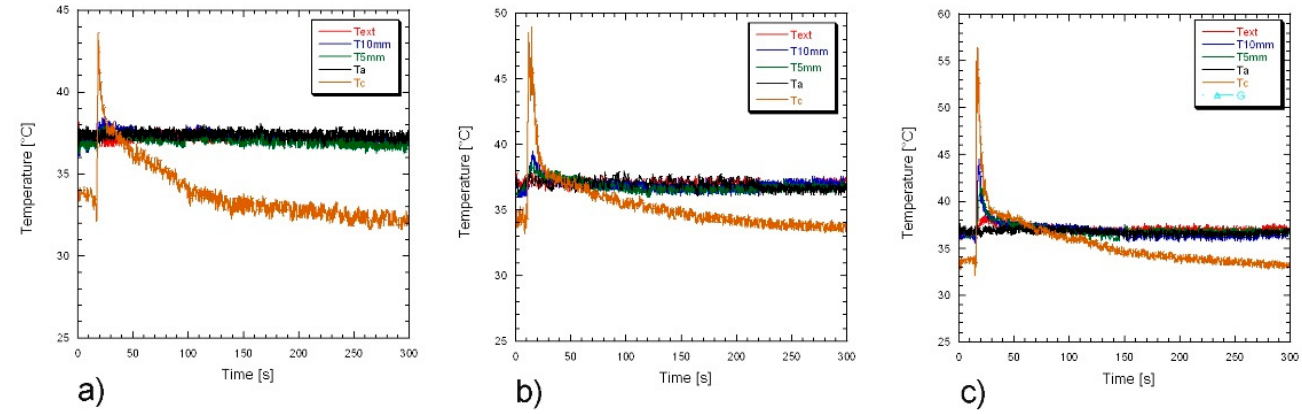
Figure 2. Temperature profiles in different regions of the tooth by extraoral heating of sodium- hypochlorite at 50 °C ( a ), 60 °C ( b ), and 70 °C ( c ). A marked temperature drop, quantified by the difference between the temperature setting of the extraoral heating system and the peak temperature measured by the thermocouple (Tc) positioned at the cervical third level (Figure 2), was recorded as NaOCl solution was injected into the root canal. The temperature drop of 6.5 °C (±1.9 °C), 11.3 °C (±2.2 °C), and 13.7 °C (±2.8 °C) was obtained at heating of 50 °C, 60 °C, and 70 °C, respectively. Concerning extraoral heating at 50 °C (Figure 2a), a negligible temperature increase was recorded by the Text, T10mm, and T5mm thermocouples suggesting that the NaOCl solution quickly cools down in all the root regions. A slight temperature increase of about 2 °C was observed as NaOCl solution was heated to 60 °C (Figure 2b). Finally, in case of NaOCl solution heated at 70°, temperature peak levels of 44 °C (±2.5 °C) and 42 °C (±2.6 °C) were recorded by the T10mm and T5mm thermocouples, respectively (Figure 2c). 3.2. Intracanal Heating Temperature